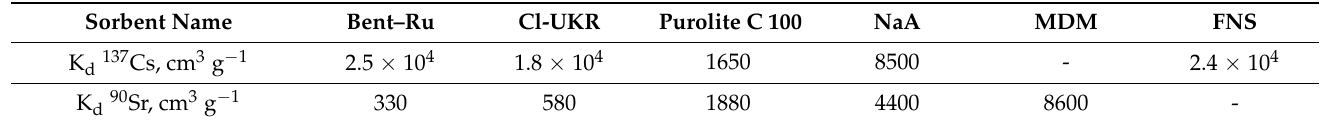
Table 3. The distribution coefficient (K d ) values of 137 Cs and 90 Sr during sorption from river water on various sorbents.